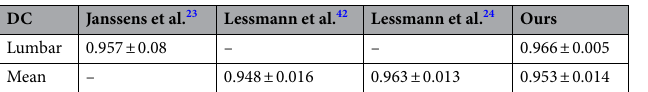
Table 8. Comparison with several deep-learning state-of-the-art